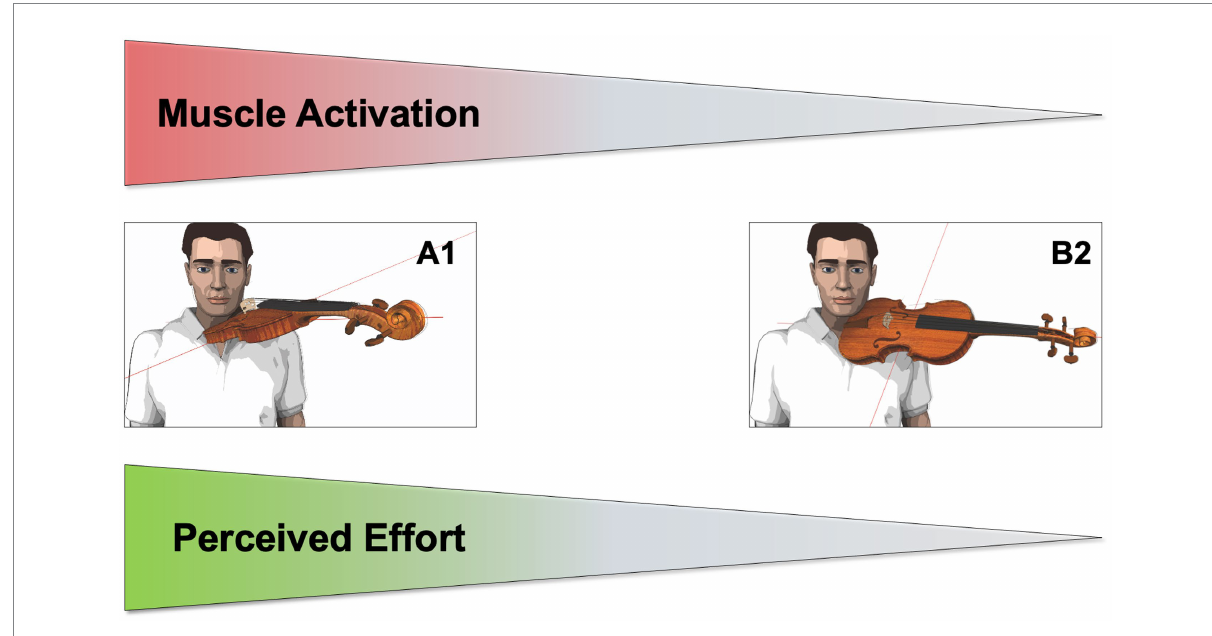
FIGURE 1 Schematic illustration of the influence of an instrument’s sidewards orientation and inclination on muscle activation and perceived